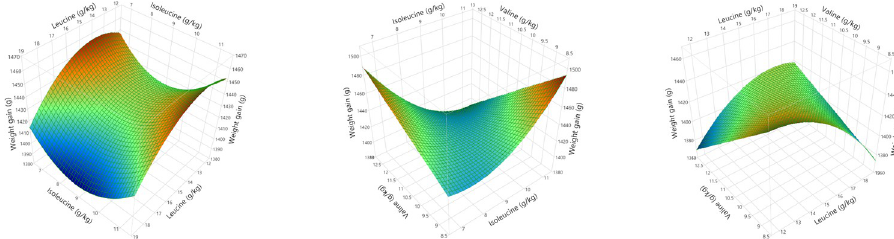
Fig 4. Response surfaces showing the relationship between weight gain and dietary digestible branched chain amino acids in male broilers from 7 to 28 days